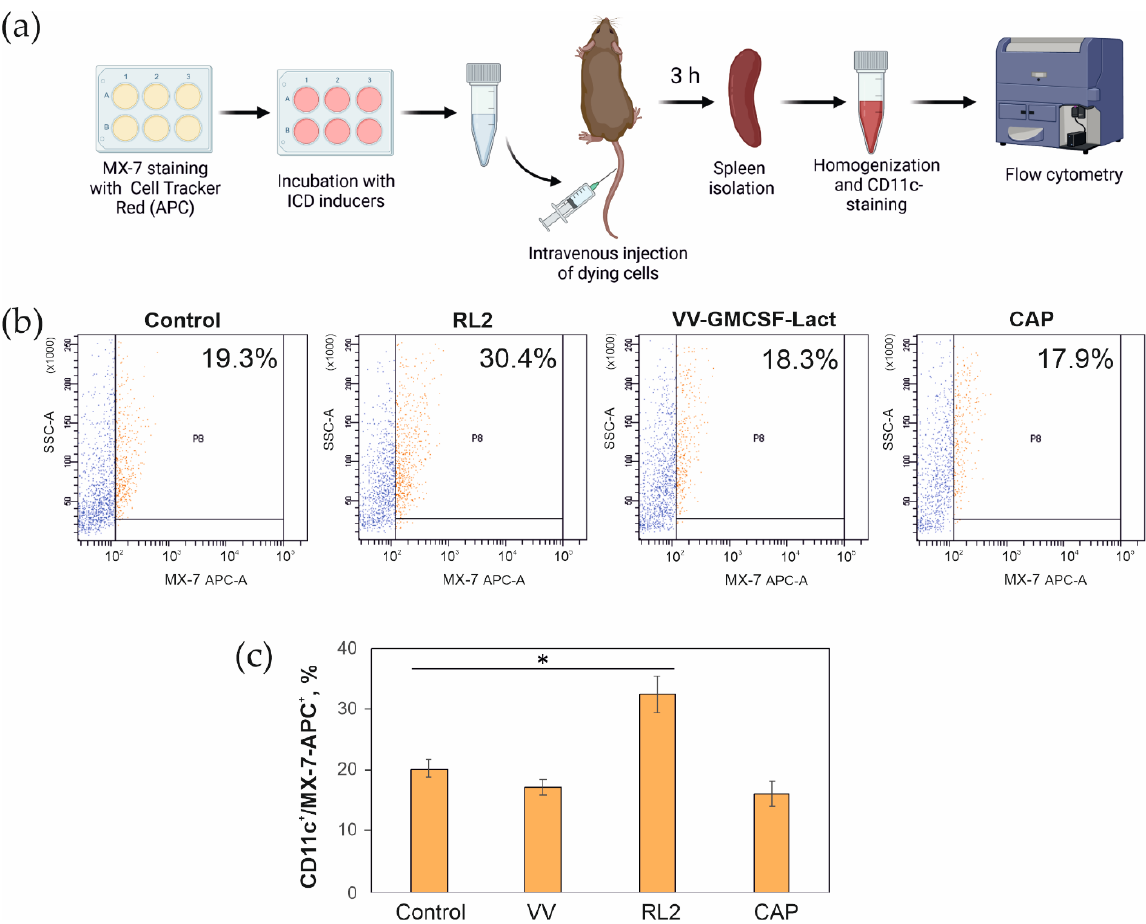
Figure 5. Capture of MX-7 tumor cells by CD11c + mouse spleen cells in vivo. ( a ) MX-7 cells were prestained with Cell Tracker Red (5 µM), treated with RL2 (0.3 mg/mL, 24 h) or VV-GMCSF-Lact (VV, 0.5 PFU/cell, 48 h), or irradiated with CAP (1 min, helium 9 L/min, 4.9 kV; 24 h after irradiation). After treatment, the dying cells were injected intravenously into C3H/He mice. After 3 h, the spleens were removed, crushed, stained with antibodies to CD11c, and analyzed by flow cytometry. ( b ) Representative images of the spleen APC + MX-7 uptake assay. The proportion of APC + cells is represented by the total number of CD11c + cells in the samples (APC: Ex = 650 nm, Em = 660 nm). ( c ) Average values of the CD11c + cell population which captured dying MX-7 cells. Data are presented as mean ± SD ( n = 4). Statistical differences between control and experimental groups are indicated by * for p < 0.05.